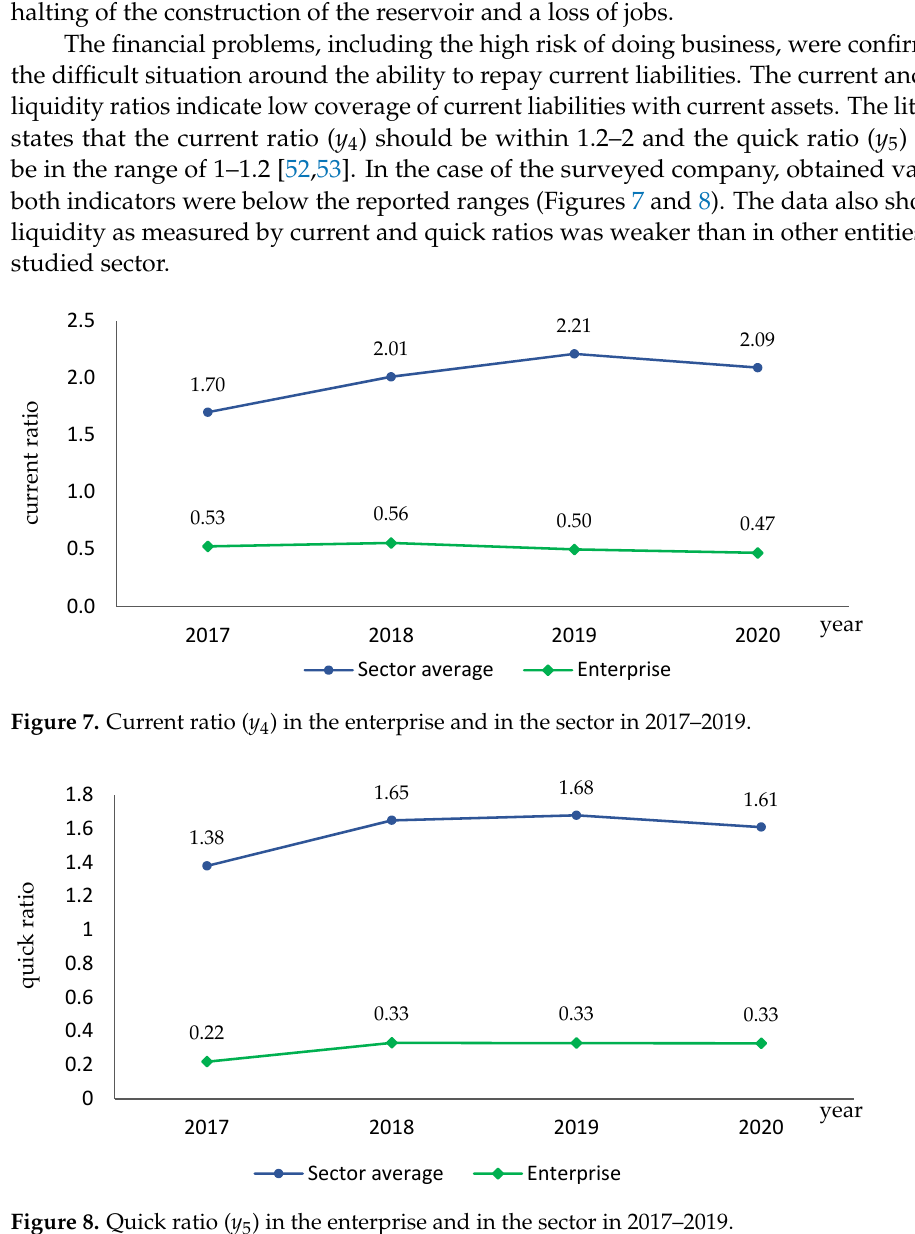
Figure 8. Quick ratio ( y 5 ) in the enterprise and in the sector in 2017–2019.